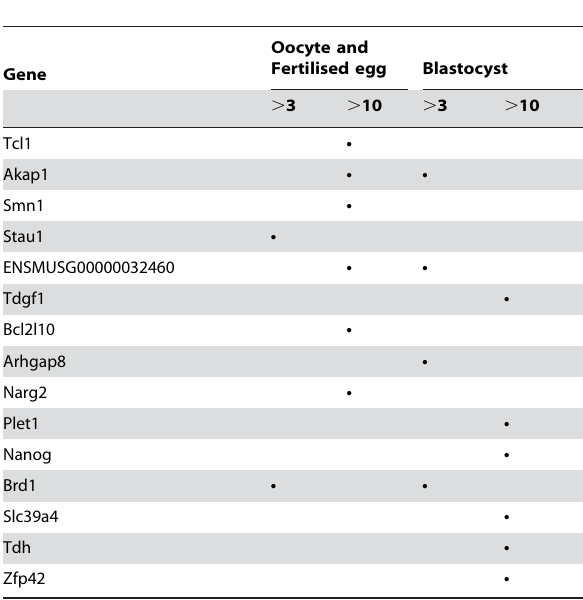
Patterns of expression in blastocysts, oocytes and/or fertilised eggs of genes with differential methylation between ES cells and pMEFs (Figure 3A) as retrieved from SymAtlas [76]. Values of expression indicated are in multiples of the median expression. Where no mark is shown expression for that gene in cell type was , 3 fold over the median expression. Patterns of expression relative to the median within the oocyte and fertilised egg were for these genes the same so were combined. Genes are selected from Figure 3A; only those with expression enriched in blastocysts, oocytes and/or fertilised eggs are shown in the table.